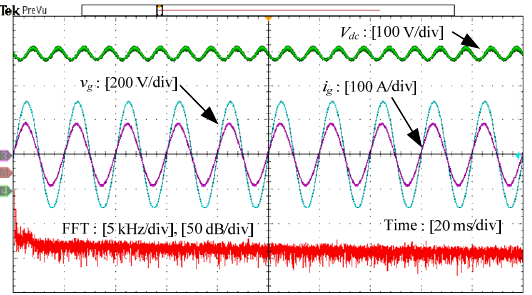
Figure 17. Experimental results of the HSTT with a discrete inductor-based LCL-type filtered single-phase converter.